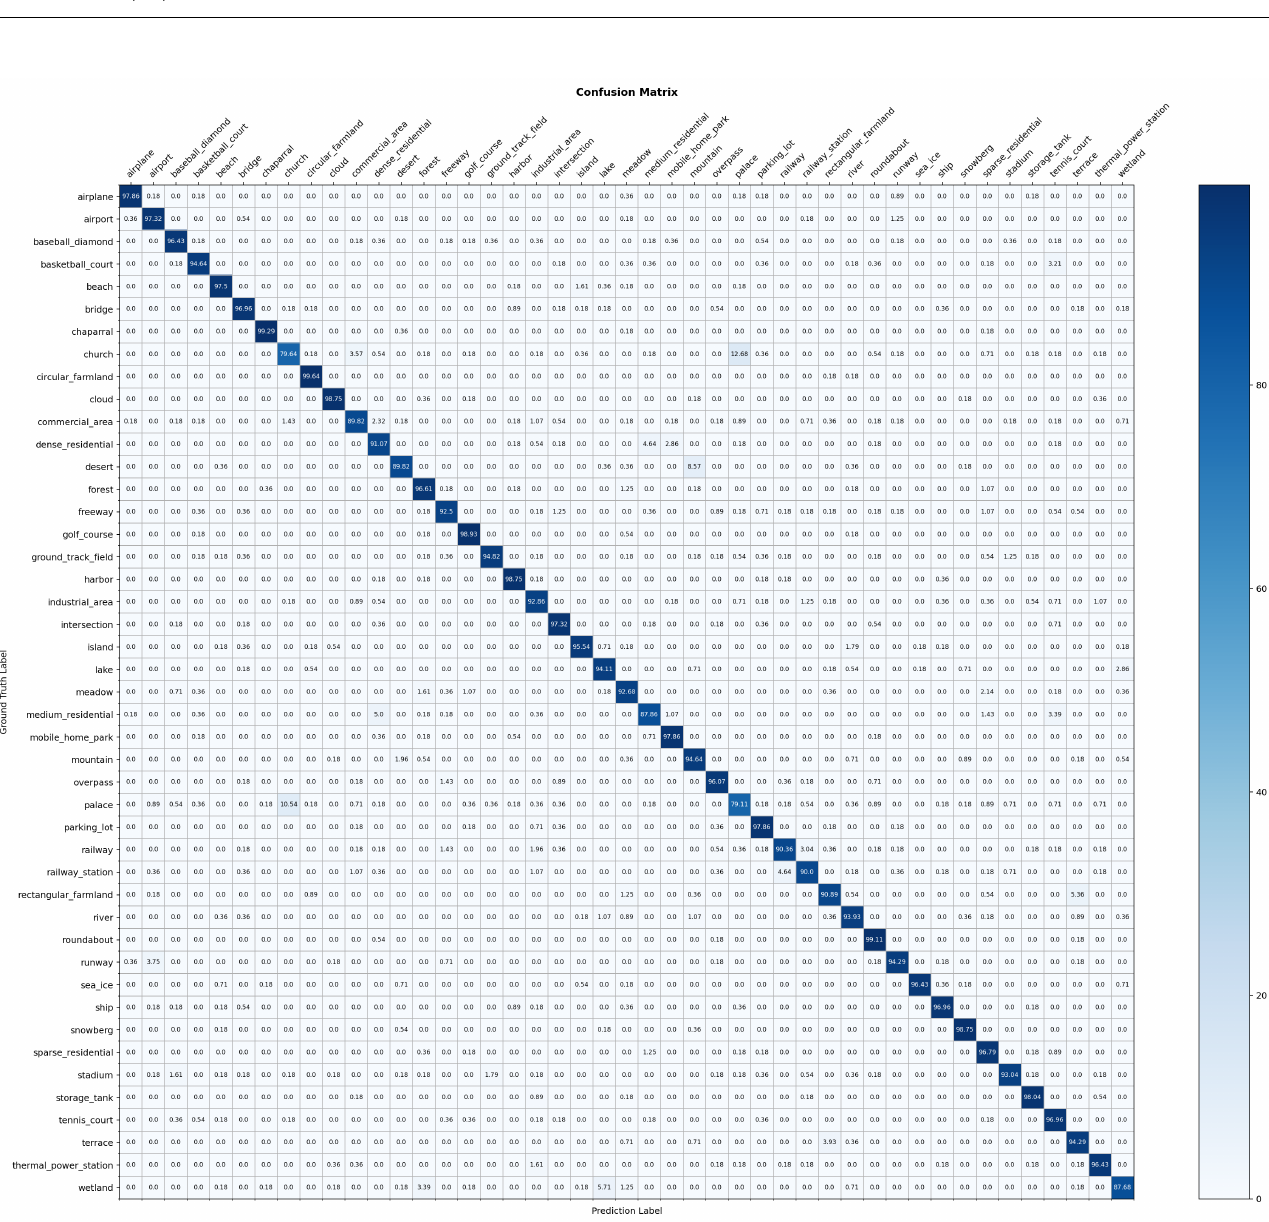
Figure 6. Confusion matrix for NWPU dataset under 20% training